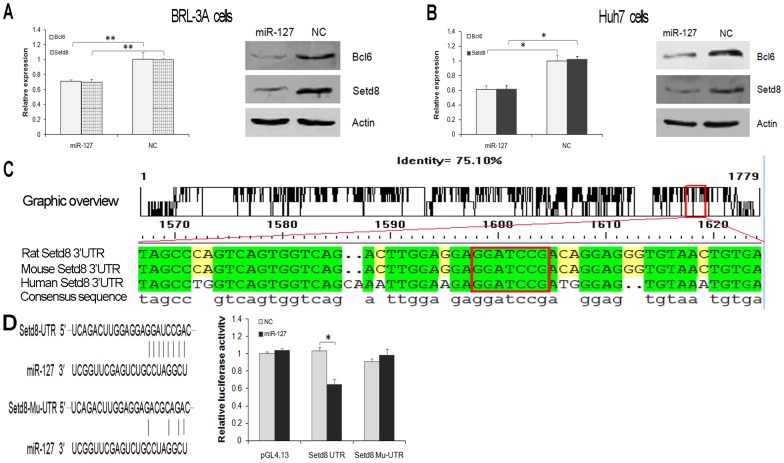
MiR-127 down-regulates Bcl6 and Setd8 expression.(A and B) BRL-3A (A) and Huh7 (B) cells transfected with miR-127 mimics or miRNA NC were analyzed by qRT-PCR (left) and Western blotting (right), respectively. Actin was used as a control. (C) Graphic overview of the conserved 3′UTR sequences of Setd8 among rat, mouse and human. The “seed sequences” in the 3′UTRs of Setd8 mRNA were indicated (red box). (D) The repression of Setd8 gene mediated by the 3′-UTR was analyzed by luciferase reporter assay. BRL-3A cells were cotransfected with a luciferase reporter vector containing the 3′-UTR or the mutated 3′-UTR (Mu-UTR) of Setd8 and miR-127 mimics (miR-127) or the negative control (NC). The pGL4.13 control vector was used as a control. The wild-type and mutated miR-127-binding sites in the 3′-UTR of this gene were indicated (left). Data from three independent experiments are shown as the means ± SD. (*P<0.05, **P<0.01).